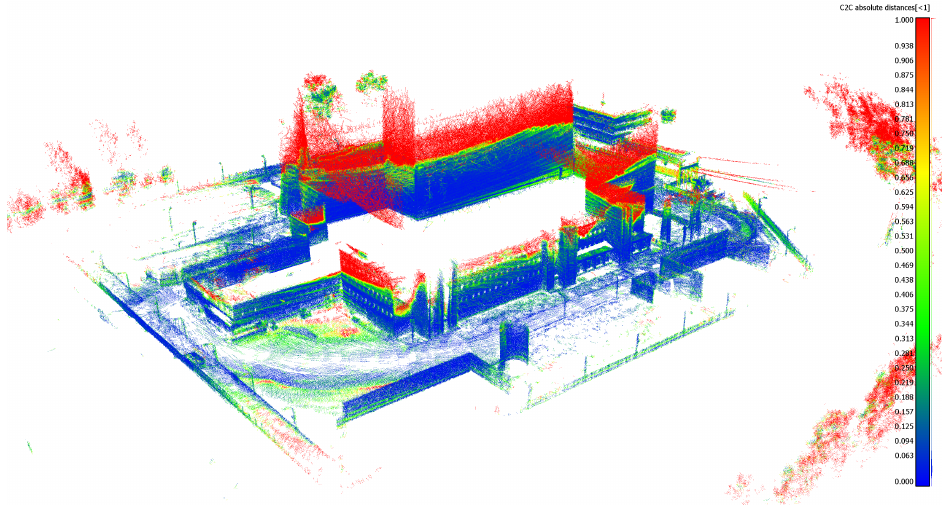
Figure 16. Undistorted, aggregated point cloud built using data from Livox Mid–40 with a rotated reflector at Zwentendorf NPP. Distance to reference point cloud from Velodyne VLP 16. The larger range of our solution and similar metric measurements compared with Velodyne VLP 16 can be